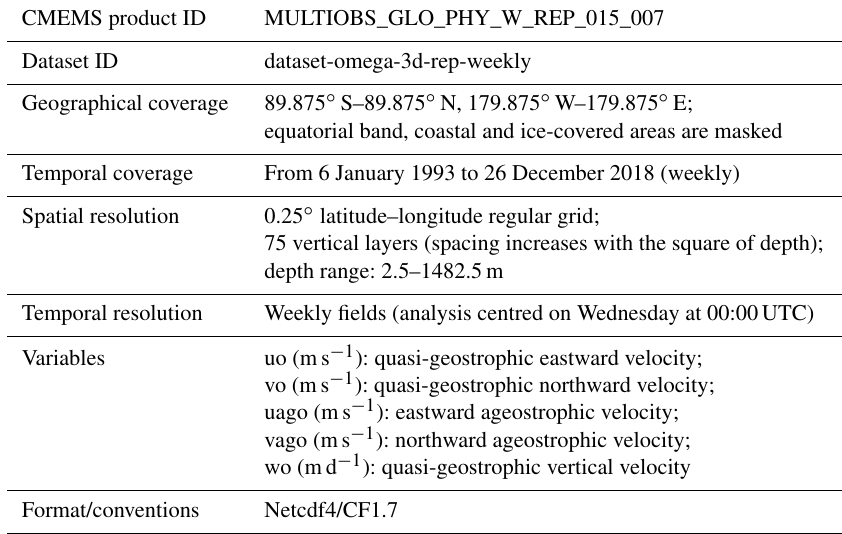
Table 1. Main characteristics of CMEMS OMEGA3D product.